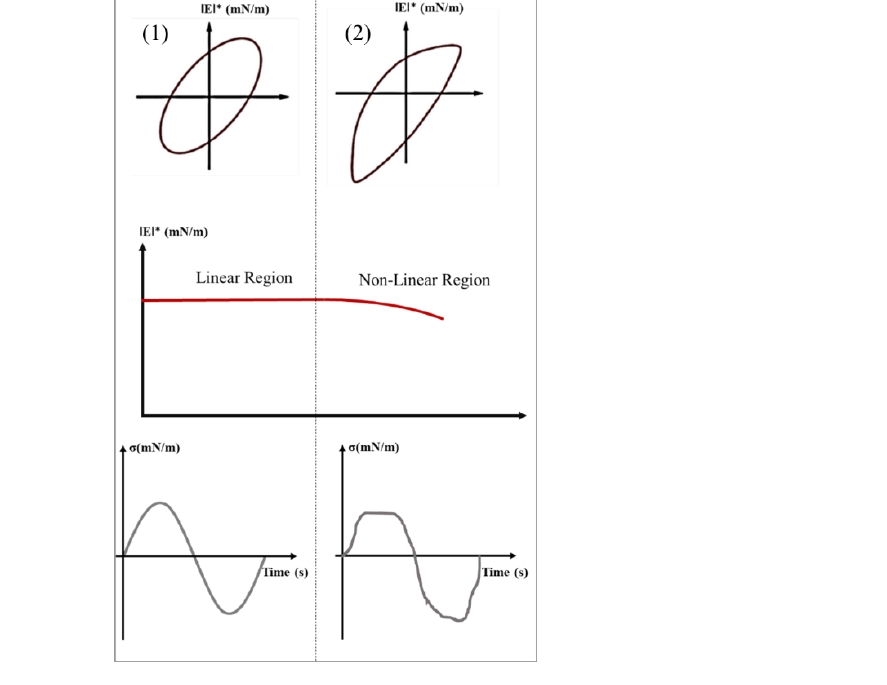
Figure 16. Lissajous plots in interfacial rheology: (1) the behavior in the linear domain and (2) the behavior in the non-linear region.